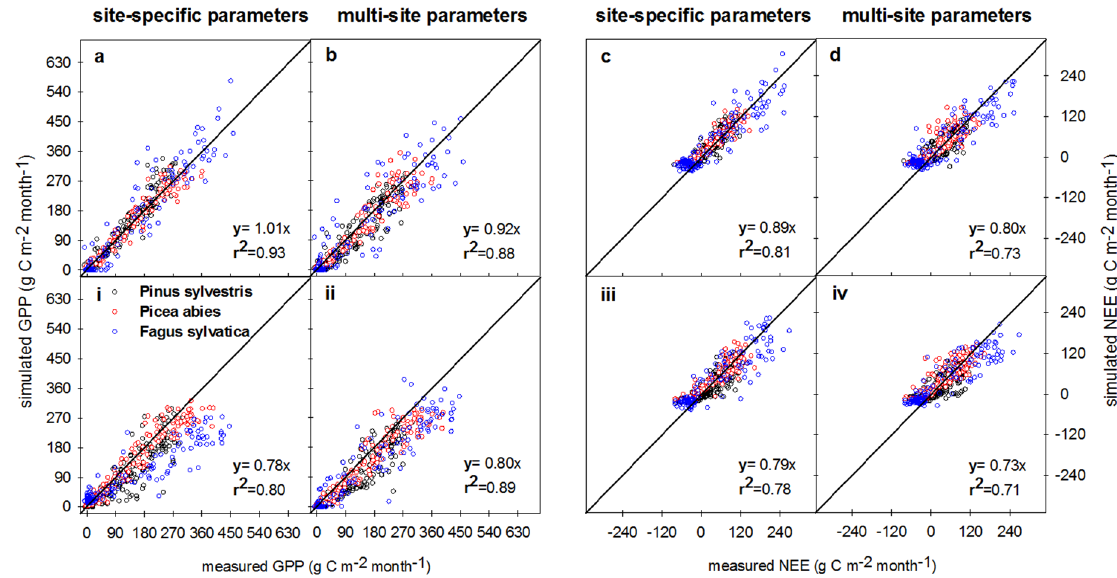
Figure 1. Comparison of monthly aggregated Gross Primary Production “GPP” (left) and Net Ecosystem Exchange “NEE” (right) for all 10 forest ecosystems for the calibration period (upper panel: ( a – d )) and the evaluation period (lower panel: ( i – iv )). Different species are pooled but indicated with different colors (see description in panel